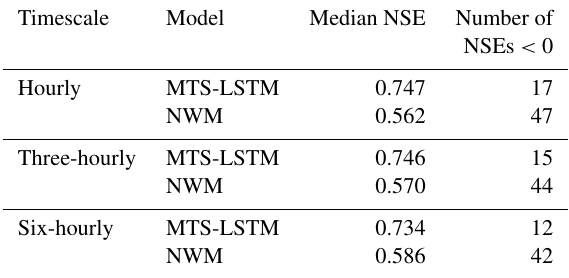
Table 7. Median test period NSE and number of basins with NSE below zero across all 516 basins for NWM and the MTS-LSTM model trained to predict one-, three-, and six-hourly discharge. The three- and six-hourly NWM results are for aggregated hourly pre-